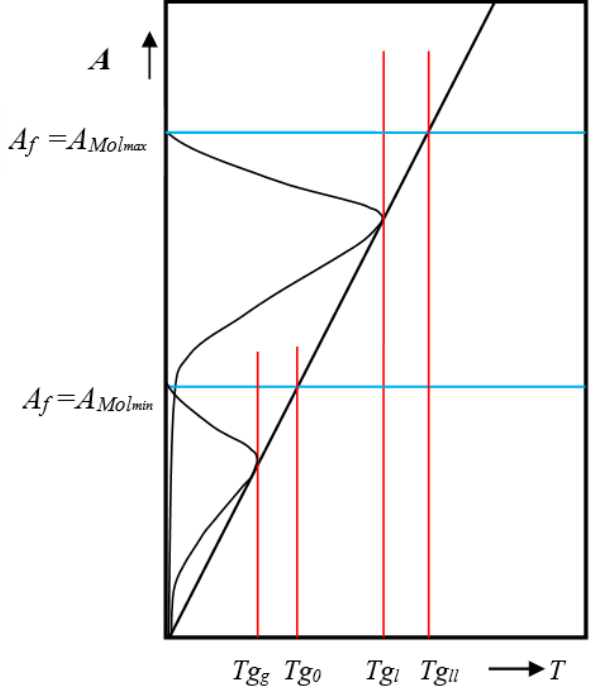
Figure 6. Limitations of viscosity regimes (schematic). The ordinate of Figure 6 exhibits the size of the cross ‐ sectional area of the temperature ‐ dependent gaps A f . The blue lines represent the cross ‐ sectional area of the smallest and larges molecular axes. The curved lines symbolize the distribution width of gaps for one distinct temperature characterized by the maximum of curves. For T < Tg g all gaps are smaller than A Molmin , the cross ‐ sectional area of the smallest molecular part, thus translational movement is no longer possible. Below Tg g there is only the solid glass. Above Tg ll the pure liquid state is reached. The upper limit Tg liq of the smallest molecular axes was not drawn for reasons of clarity.